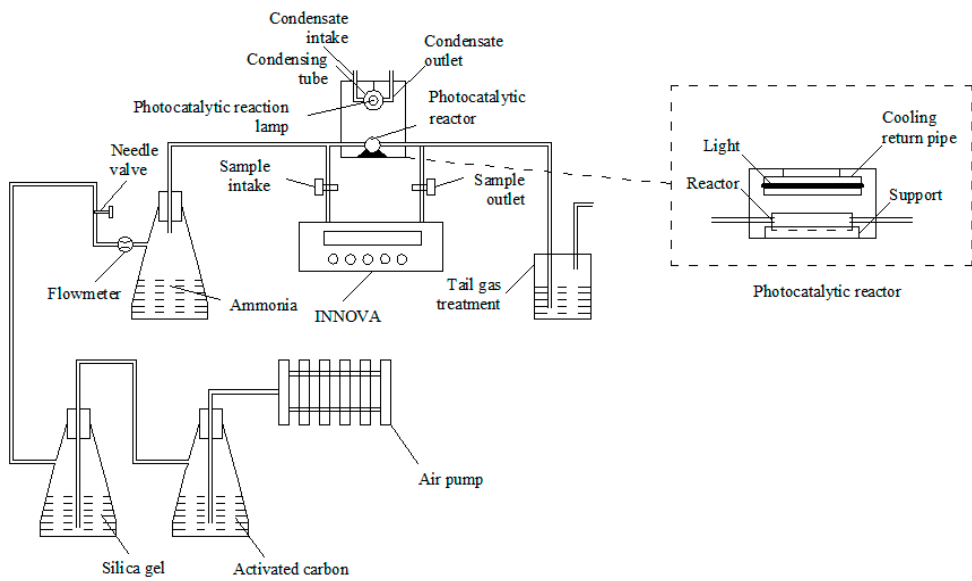
Figure 14. Schematic diagram of ammonia degradation unit.